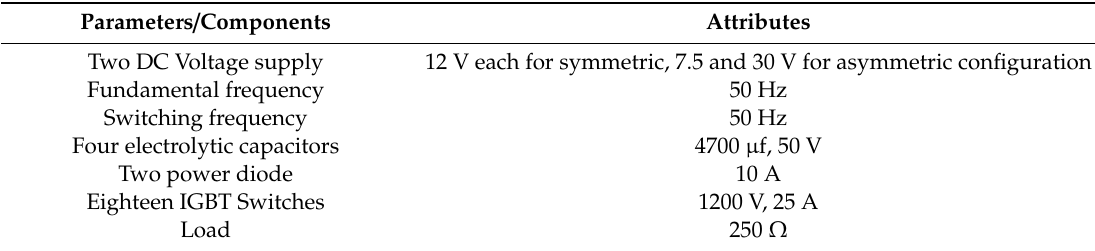
Table 7. Parameters used in simulation and